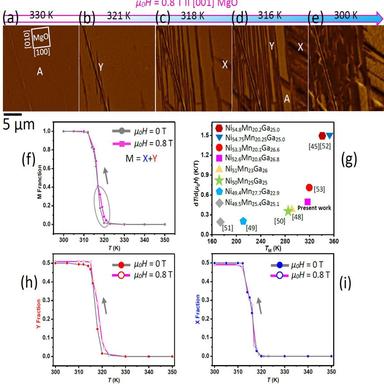
Isofield phase transition: a-e) MFM images captured upon cooling in the presence of μ0H = 0.8 T, parallel to MgO, showing the formation and coalescence of the X- and Y-type configurations. Direction of the MgO substrate is provided as a reference in (a). Some of the X- and Y-type regions as well as the austenitic areas (A) are labeled. f) Constructed martensitic fraction (M = X + Y) of the scanned area over cooling for zero-field (gray) and isofield (pink) conditions. g) Comparing the obtained dT/d(μ0H) of